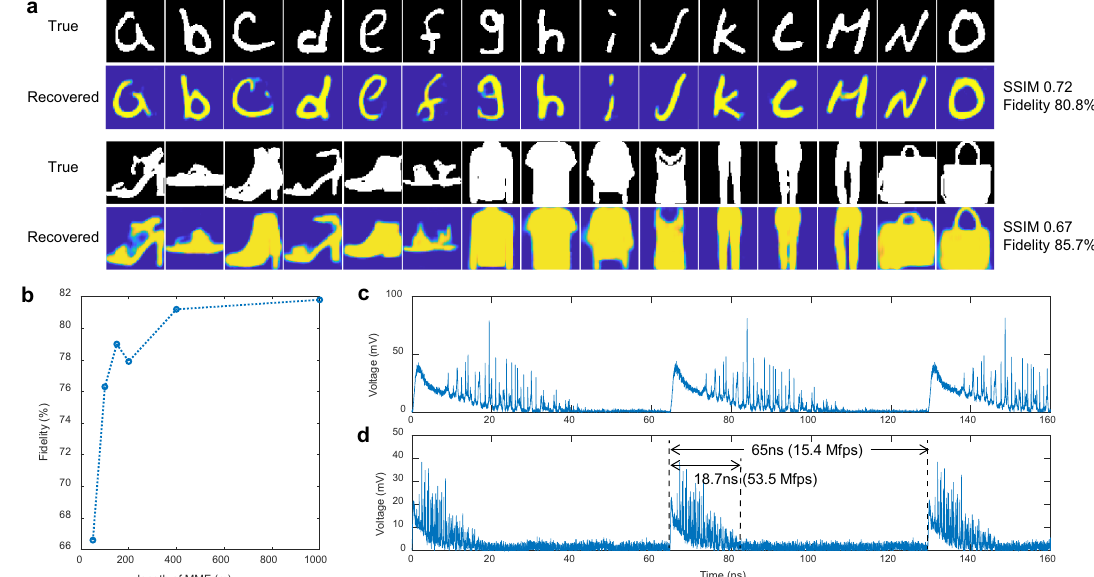
Fig. 4 Imaging performance analysis. a Example images of the letters and clothes and the recovered images. b Average fi delities when using different MMF lengths in the system. Collected time signals when the MMF length is c 1000 m and d 400 m respectively. The period of the laser pulses is 65 ns, corresponding to a repetition rate of 15.4 MHz. The width of the waveforms is 18.7 ns, which allows the repetition rate to be further increased to 53.5 MHz.